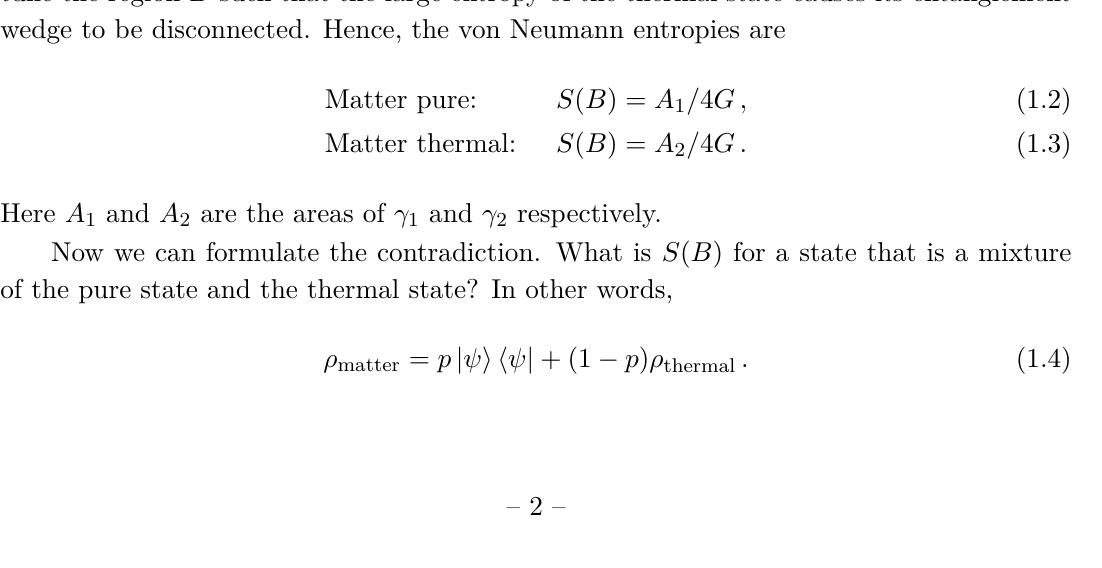
and γ , with γ homotopic to B and γ to B . We take B to be 1 2 1 2 is bigger than that of γ at O (1) . Between these surfaces is a large 2 1